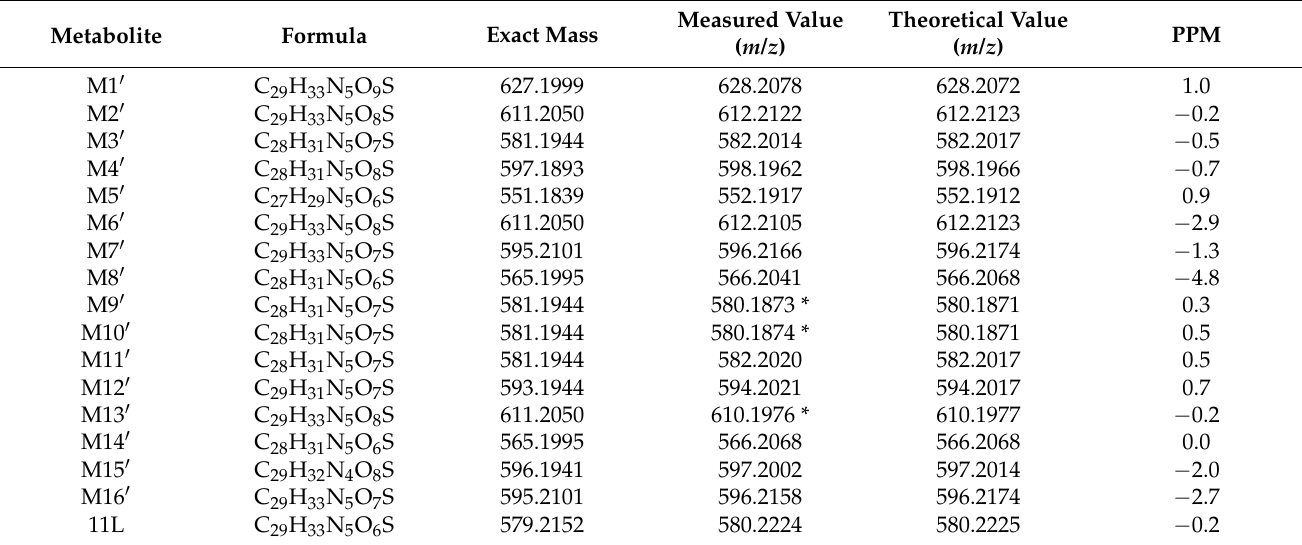
Table 4. Accurate quality detection information of 11L and its metabolites in